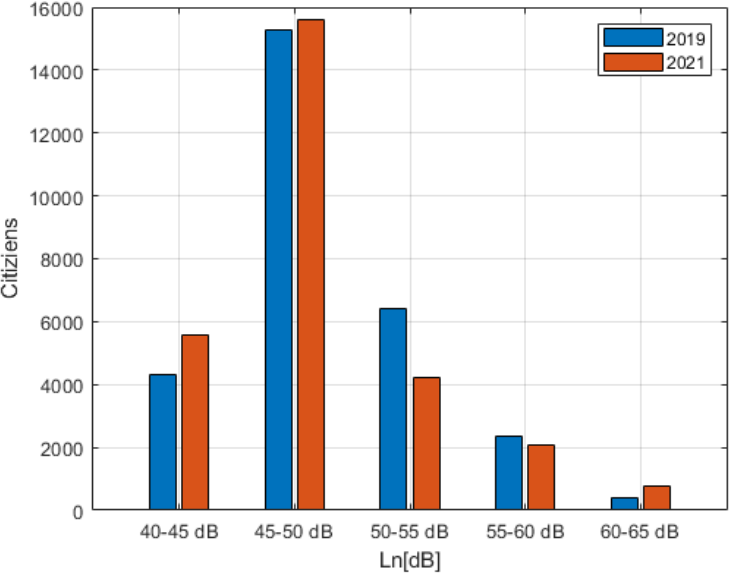
Figure 18. Population exposed to L n exposure categories for both 2019 and 2021.